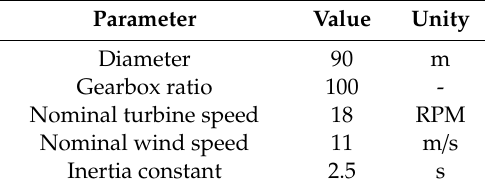
Table 2. Parameters of the wind turbine.